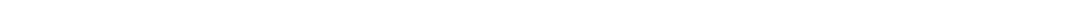
Figure 2: Diagnostic algorithm of copeptin in the differential diagnosis of patients with PP, central and nephrogenic DI. A basal copeptin value of ≥21.4 pmol/l confirms the diagnosis of nephrogenic DI. A basal copeptin value of <21.4 pmol/l needs an osmotic stimulation (water deprivation or hypertonic saline infusion) to differentiate between central DI and PP. An osmotically stimulated copeptin value ≥4.9 pmol/l differentiates between patients with central DI and PP with a high diagnostic accuracy [28].Adapted from Christ-Crain and Fenske (2016)